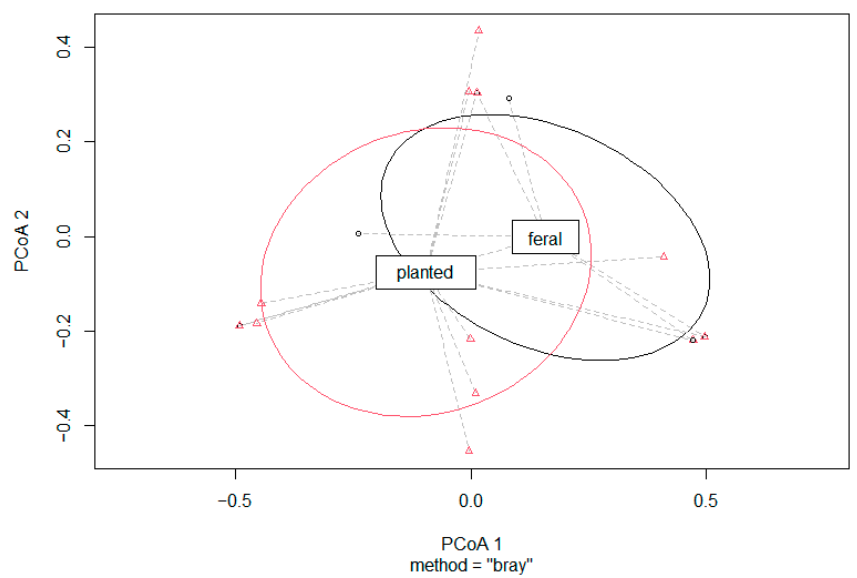
Figure 3. Abundance of each pollinator taxon identified from planted and feral P. calleryana . Domi- nant taxa were European honeybee ( Apis mellifera ) and mining bees ( Andrena spp.), and other taxa included wasps, native bees, hoverflies, and other flies.